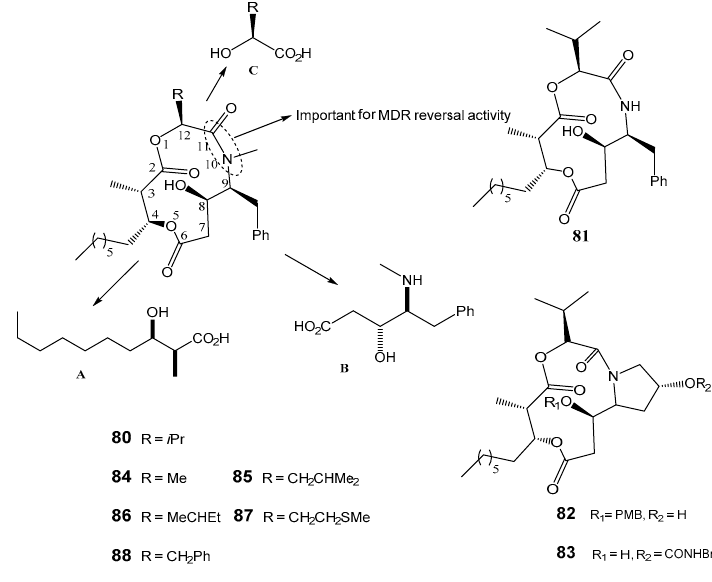
Figure 17. Structure of hapalosin ( 80 ) and analogs 81 – 88 highlighting the important domains for synthesis ( A – C ).